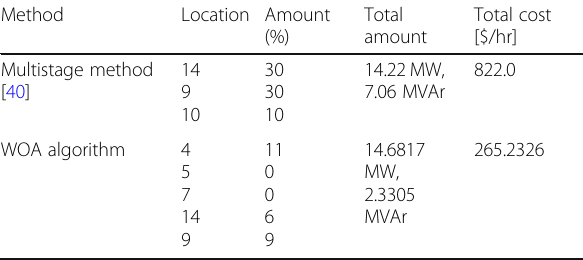
Table 1 Comparison of two approaches of EEDR (IEEE